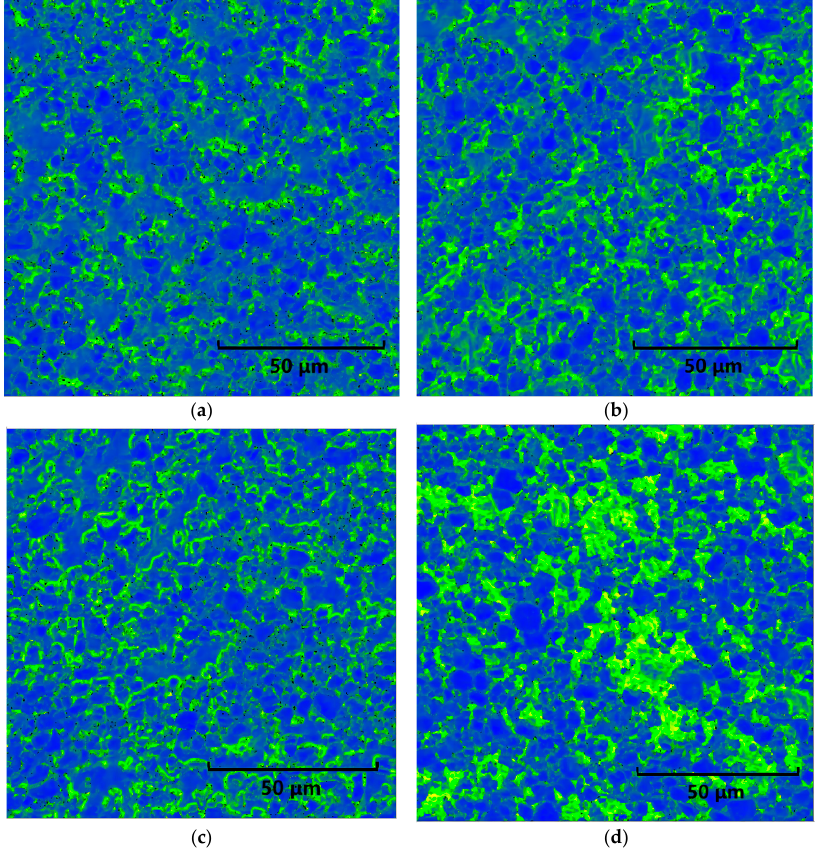
Figure 5. EBSD map for GND calculation with different heat input: ( a ) sintered; ( b ) 3.4 KJ/cm; ( c ) 6.2 KJ/cm; ( d ) 7.9 KJ/cm.